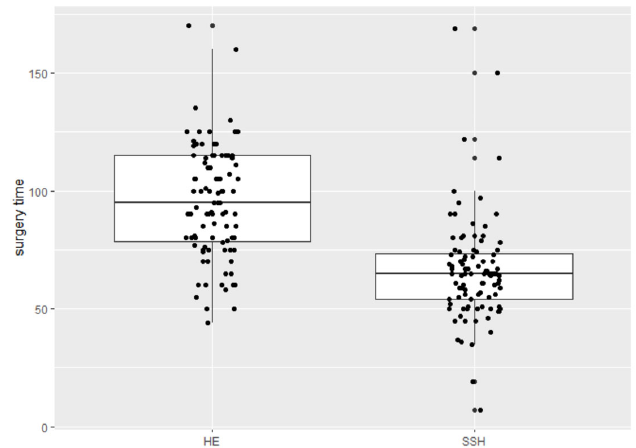
Figure 2. Surgery time in minutes .